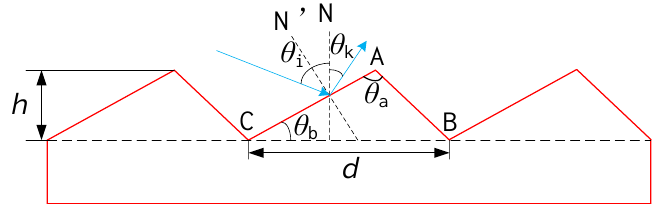
Figure 1. Working principle of reflective blazed grating.